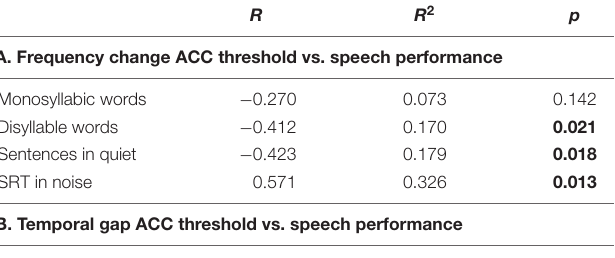
TABLE 2 | Simple linear regression